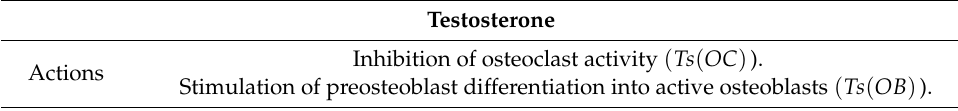
Table 4. Testosterone actions and their mathematical